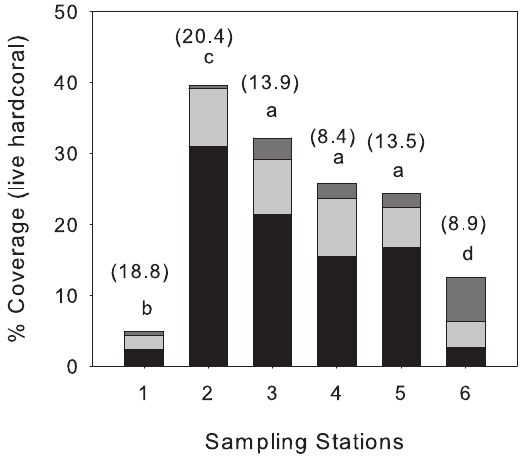
Figure 2. Percent coral coverage of plate Acropora , caespito- corymbose Acropora and other coral species at Ningaloo reef. Six stations were sampled in autumn (March - April 2010). Numbers in brackets represent long-term average current speed per station and same letters indicate no significant difference in total coral coverage per